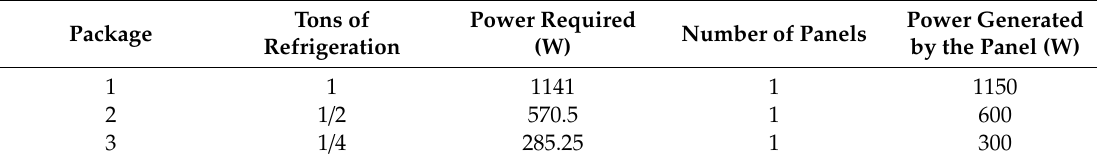
Table 2. Number of photovoltaic (PV) panels and power for each compressor.